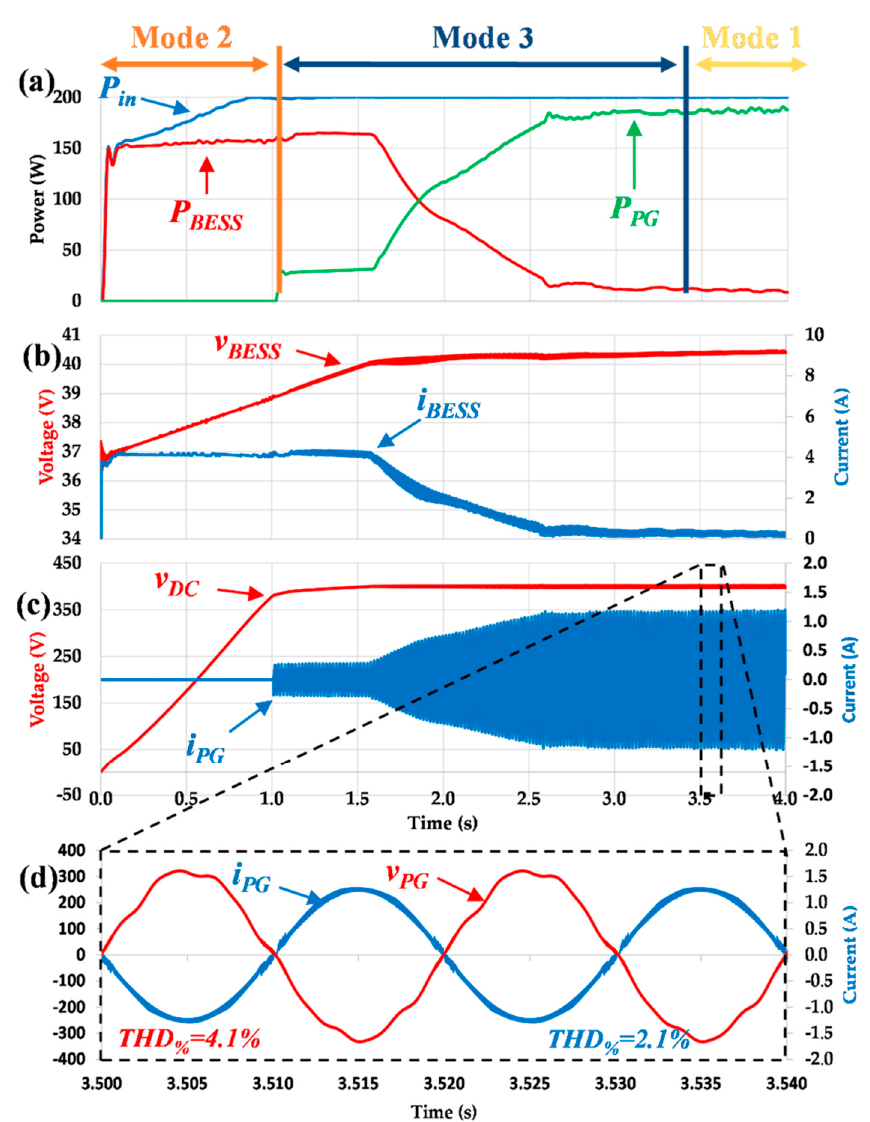
Figure 9. Simulation results of the multifunctional isolated microinverter: ( a ) Input power ( P in ), power used to charge the BESS ( P BESS ) and power injected into the power grid ( P PG ); ( b ) Voltage ( v BESS ) and current ( i BESS ) during the BESS charge; ( c ) DC-link regulation, showing the voltage in the DC-link ( v DC ) and the current ( i PG ) produced by the DC–AC power converter; ( d ) Detail of the current ( i PG ) and voltage ( v PG ) of the power grid.